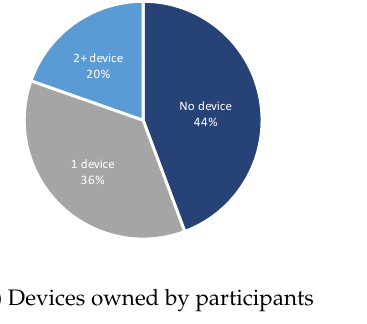
Figure 2. Exposure to IoT devices and level of security